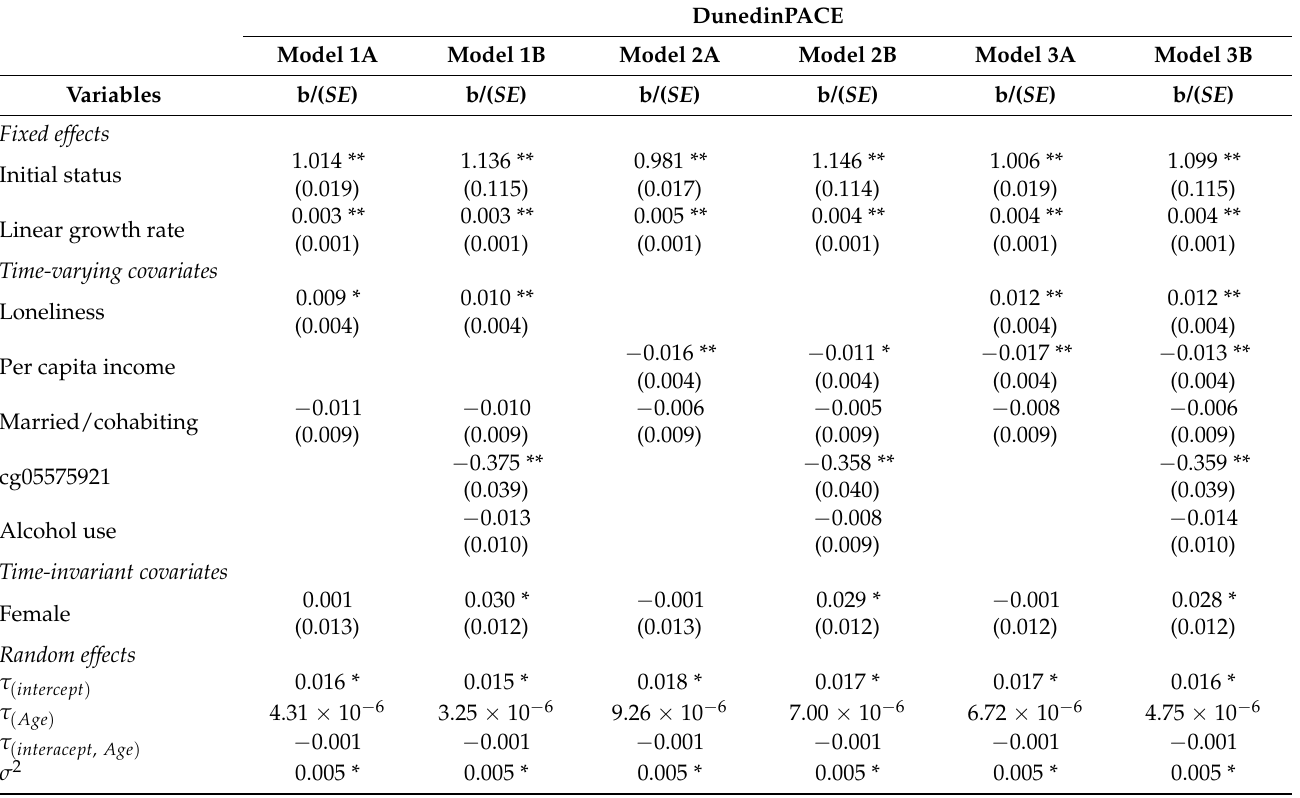
Table 3. Parameter estimates for linear growth models with time-varying and time-invariant covari- ates examining the separate and joint effects of loneliness and per capita income on DunedinPACE ( n =